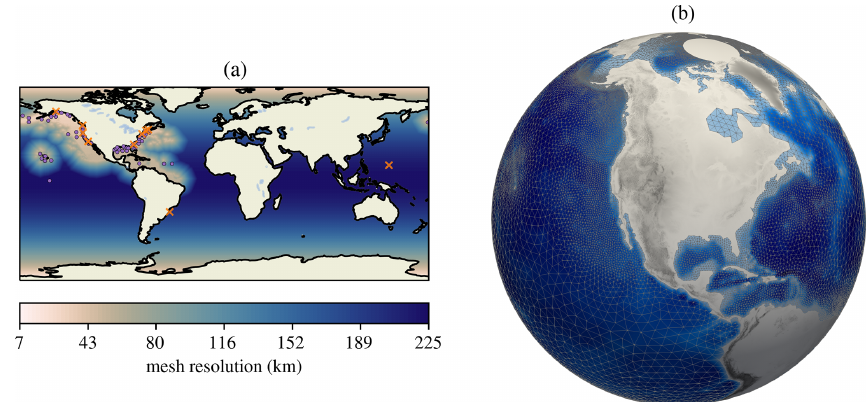
Figure 2. Unstructured mesh with global 2 ◦ resolution and 0.5 ◦ resolution in regions with depths of less than 4km within the coastal US: (a) quantitative mesh resolution and (b) qualitative mesh resolution and bathymetry. In panel (a) , dots indicate stations used in the validation, while X indicates those excluded as explained in Sect. 3.6.